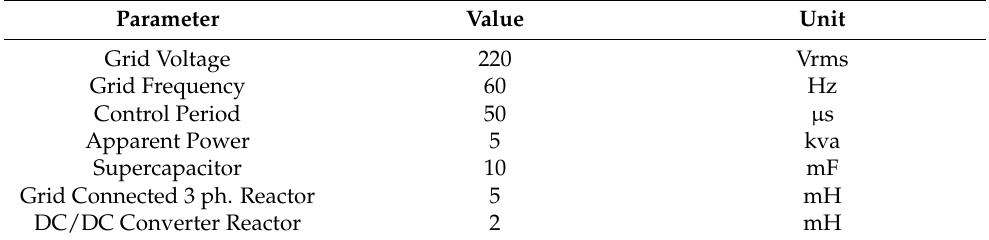
Figure 26. OPAL-RT block diagram of a grid-connected device including the proposed power compensator. Table 3. OPAL-RT parameters for grid-connected devices with power compensators.